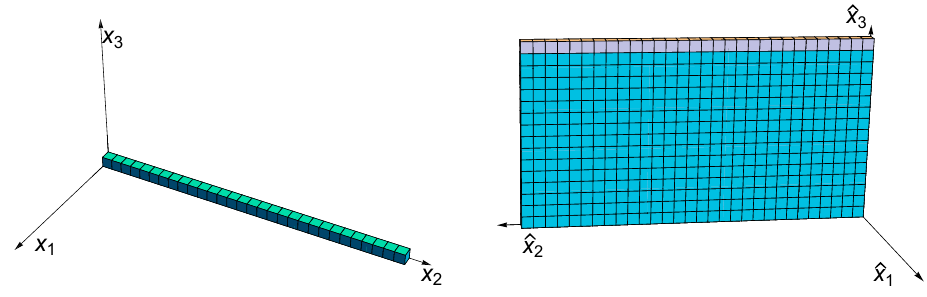
Figure 2 . (cid:4) = ( (cid:3) ; (cid:22) (cid:3) ) as a twin plane partition. Left (Right): from perspective of Y ( ^ Y ). right W algebras can have the same f h g parameters. This has also been con(cid:12)rmed by 1+ 1 i checking W N =2 charges of various twin plane partition con(cid:12)gurations. For the rest of